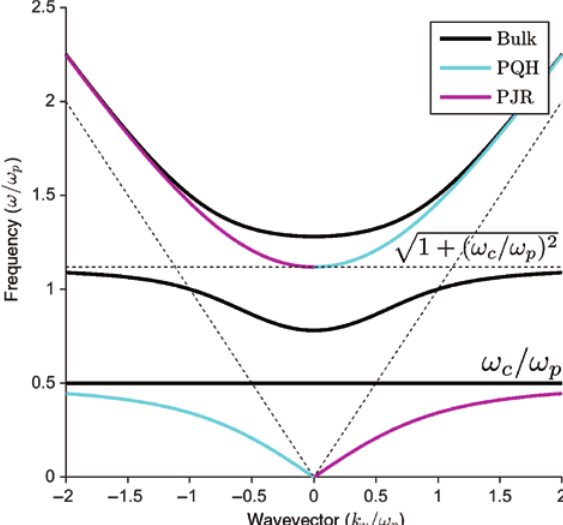
Figure 3: Dispersion relation of the local Drude model under an = 1/2 as an example. applied magnetic field with ω / ω c p Black lines indicate bulk bands while cyan and magnetic lines represent unidirectional PQH and PJR edge states, respectively. There are a total of three positive energy bulk bands. Two correspond to high and low frequency TM modes ω = ω while the third represents ± pure cyclotron orbits ω = ω . The PQH states emerge at a PMC c boundary while the PJR states require a PEC boundary. Unlike conventional surface plasmon polaritons (SPPs), the PQH, and PJR → ∞ limit. states asymptotically approach the bulk bands in the k y → k The upper branch approaches the free photon dispersion ω ↑ y → ω while the lower branch approaches pure cyclotron orbits ω ↓ c